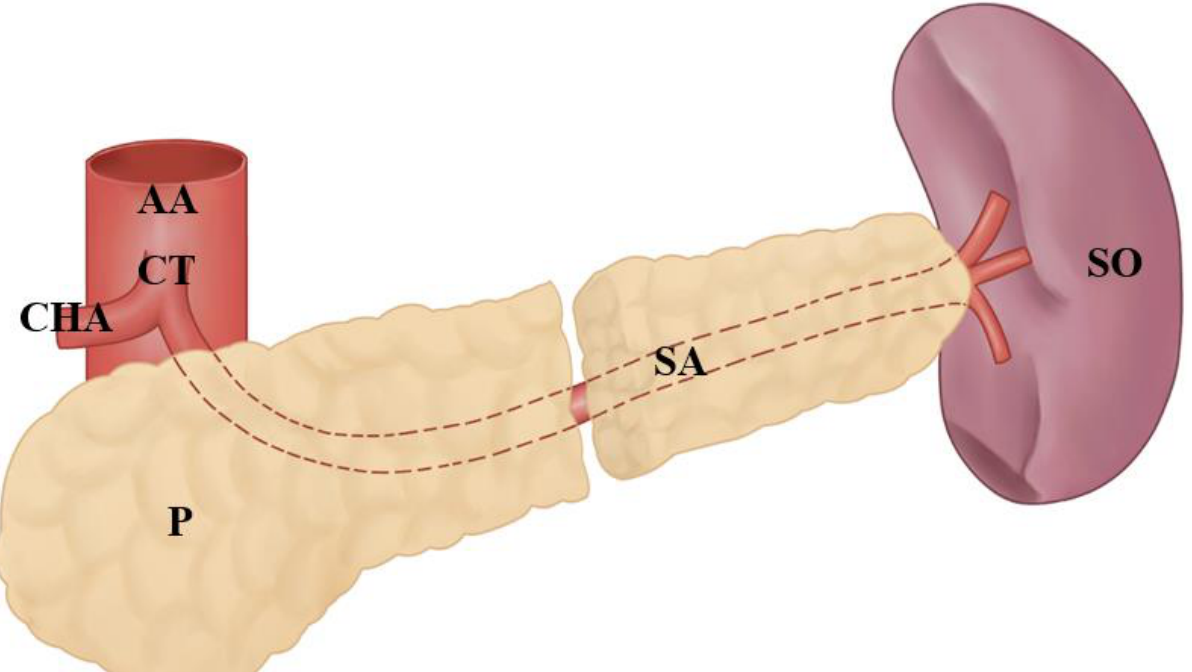
Figure 4. The image shows the retro-pancreatic splenic artery. Abbreviations: abdominal aortic (AA), splenic artery (SA), common hepatic artery (CHA), celiac trunk pancreas (P), splenic organ (SO).